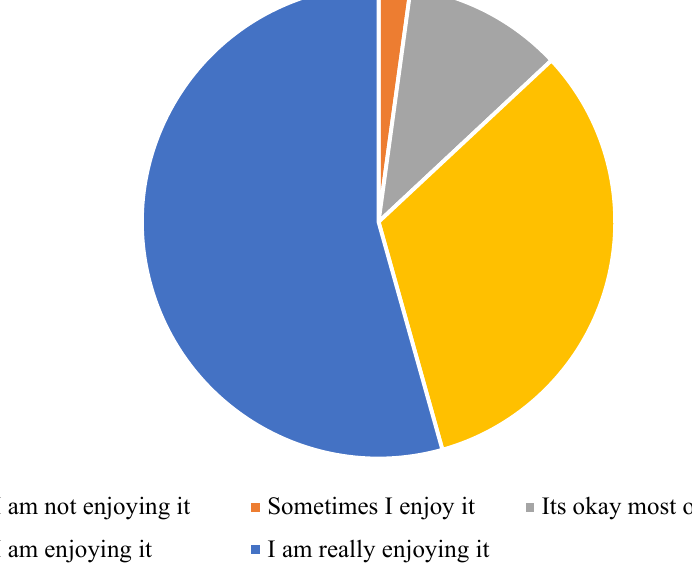
Figure 1. Students Enjoyment of Trinity Walton Club